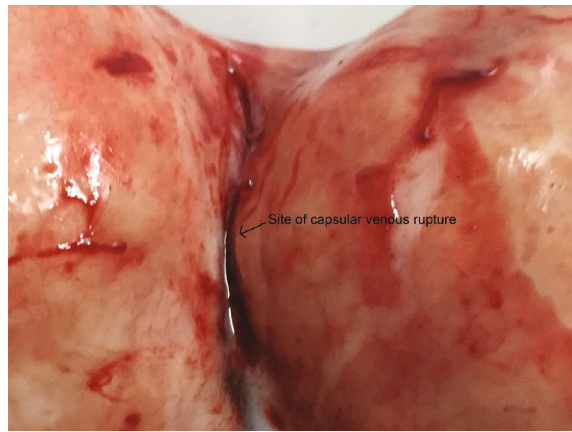
Figure 4: Site of capsular venous rupture in the subserous fi broid